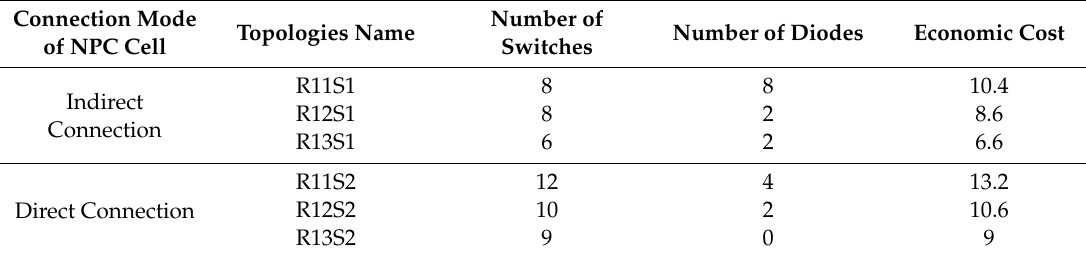
Table 6. Comparison of the Inverter topologies under